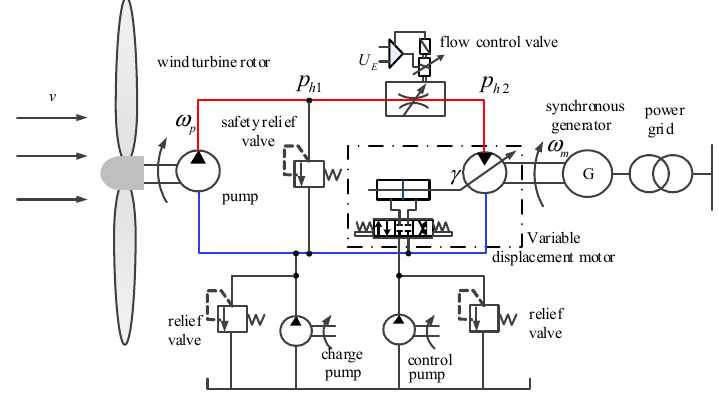
Figure 1. Schematic of the hydraulic wind turbine (HWT).